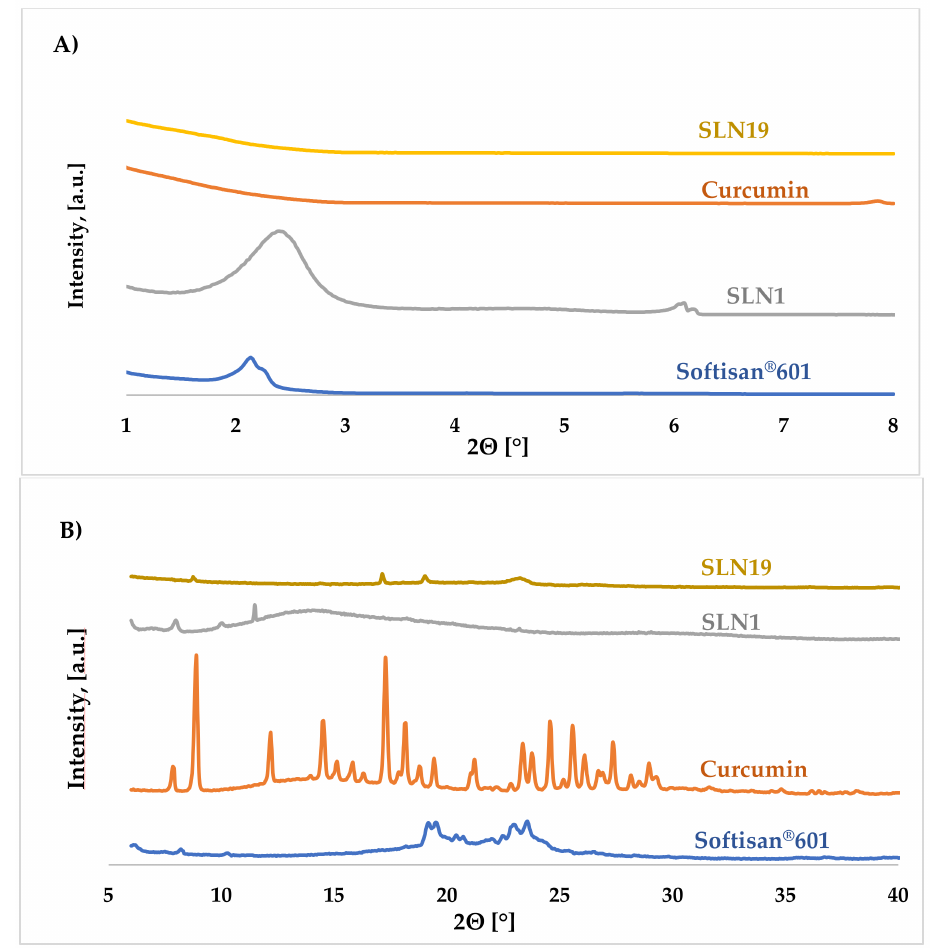
Figure 6. Comparison of XRD diffractograms: ( A ) low-angle diffractograms for Softisan ® 601, SLN1, curcumin and SLN19, and ( B ) wide-angle diffractograms for Softisan ® 601, SLN1, curcumin, and